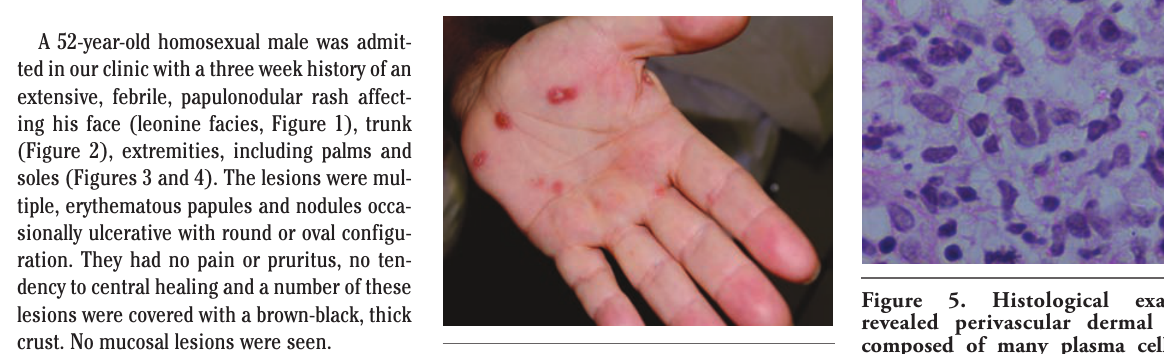
Figure 3. Erythematous papules and nod- ules on the left palm.